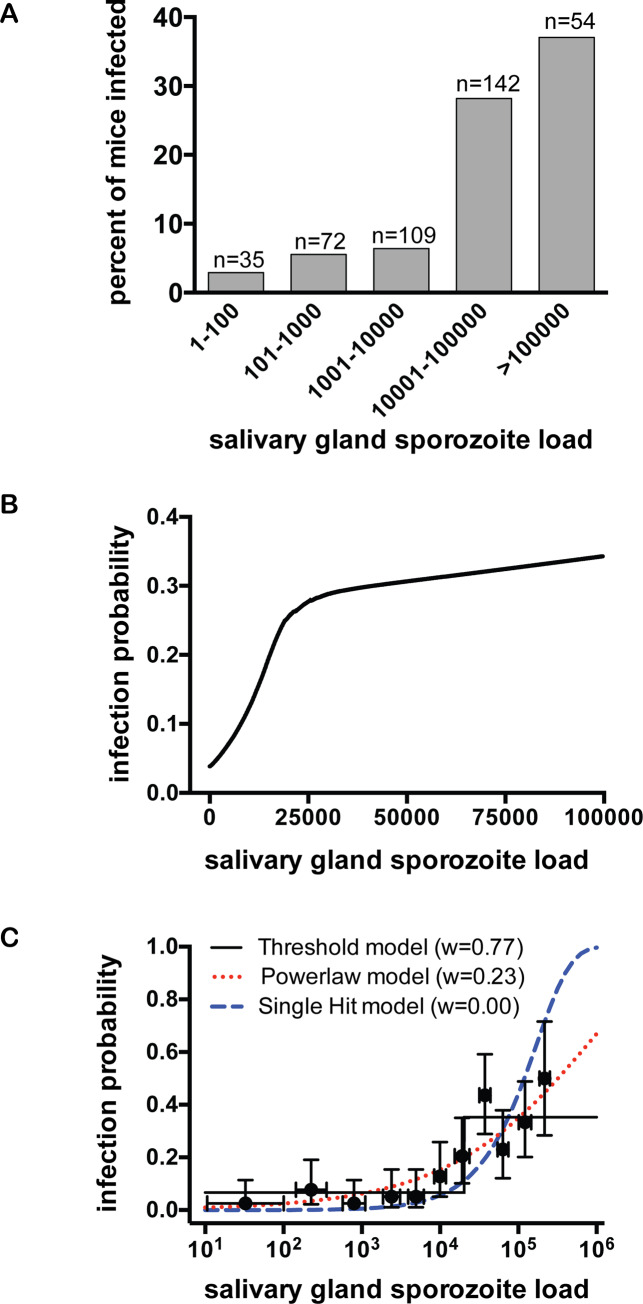
Mosquito salivary gland sporozoite load significantly impacts the likelihood of malaria infection.Single mosquito feeds were performed and subsequently salivary gland sporozoite loads were measured and mice were followed for blood stage malaria infection. Data are pooled from 20 independent experiments with 7 to 44 mice per experiment. Total n = 412 (A) Log-binning of mosquito salivary gland loads and percent of infected mice in each bin. Mosquitoes are binned using the traditional method of grading salivary gland infections on a log-scale and for each bin the percent of mice positive for malaria infection is plotted. Above each bar is the number of mouse-mosquito pairs in each bin (n). (B) Logistic regression analysis of the probability of malaria infection as it relates to salivary gland sporozoite load. Predicted probability of malaria infection, from logistic regression with a linear spline at 20,000 salivary gland sporozoites, is plotted against mosquito sporozoite load and shown is the smoothed Lowess curve. A statistically significant relationship between salivary gland load and probability of malaria was observed (p<0.001). The x-axis is cut at 100,000 to focus on sporozoite loads more commonly observed in the field. Logistic regression plotted for the full range of sporozoite loads in our dataset is shown in S2 Fig. (C) Mathematical modeling of infection probability as it relates to salivary gland sporozoite load. Three alternative models, (single hit, powerlaw, and threshold), were fit to the entire raw dataset (n = 412) and compared using Akaike Information Criterion to generate Akaike weights (w). The threshold model best describes the probability of malaria infection as a function of salivary gland sporozoite number (highest weight). The data points on the graph are shown for illustrative purposes: Raw data were binned with equal number of mosquitoes in each group (n = 41), except the last group, which has 43 mosquitoes. Error bars on the y-axis show 95% confidence intervals calculated using Jefferey’s intervals for binomial distribution [66] and on the x-axis show 67% confidence intervals calculated using normal distribution. The single hit, powerlaw, and threshold models are described in the Materials and Methods by Eqs 1, 2 and 3, respectively) and fit was determined using the maximum likelihood method (Eq 6 in Materials and Methods).